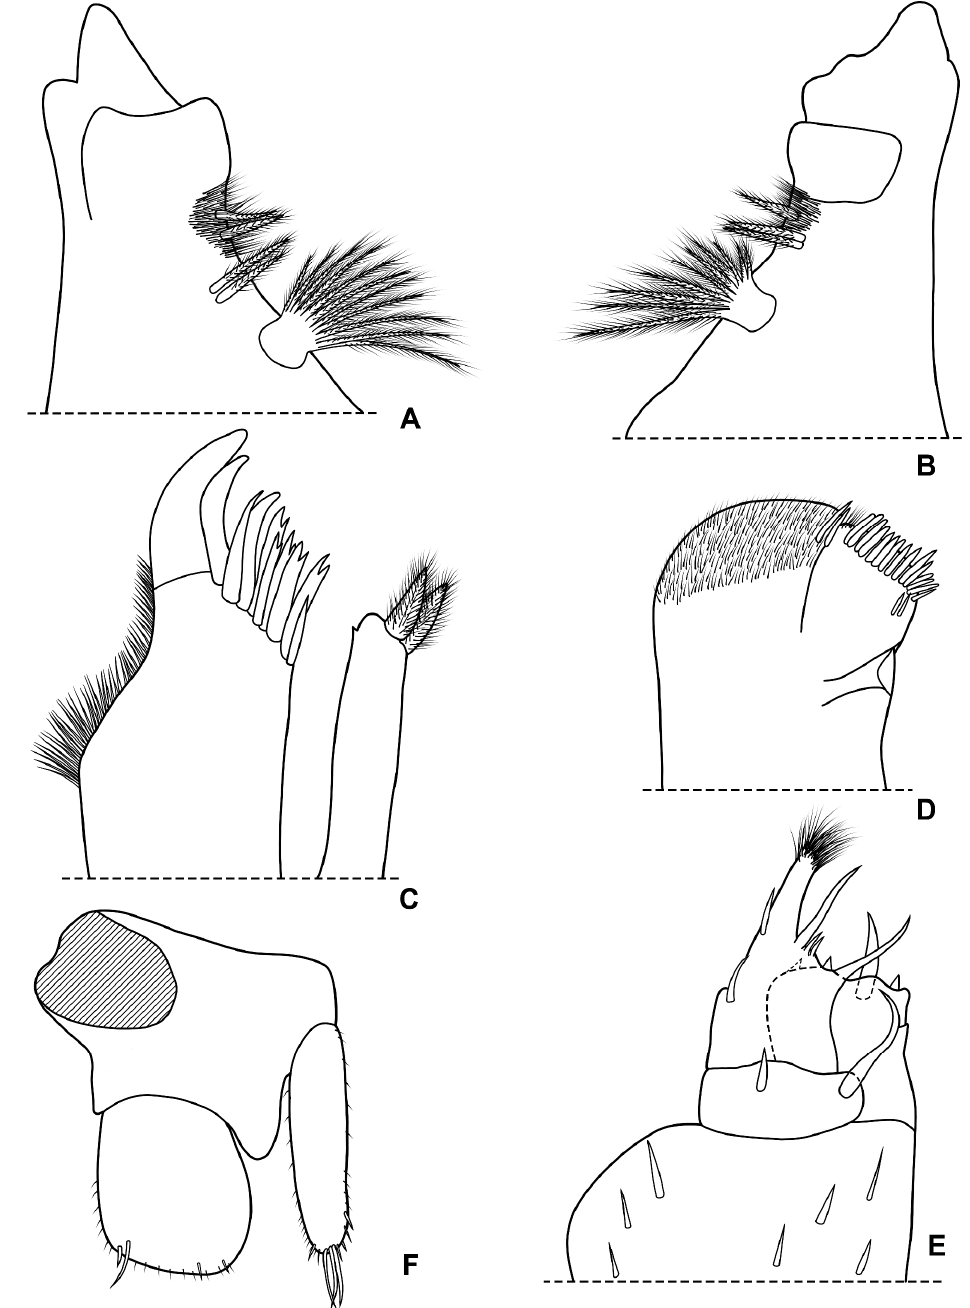
Figure 14. Alloschizidium segestanum sp. n., paratype ♀ from Punta Manara. ( A ) Left mandible. ( B ) Right mandible. ( C ) Maxillula. ( D ) Maxilla. ( E ) Maxilliped. ( F ) Left uropod.